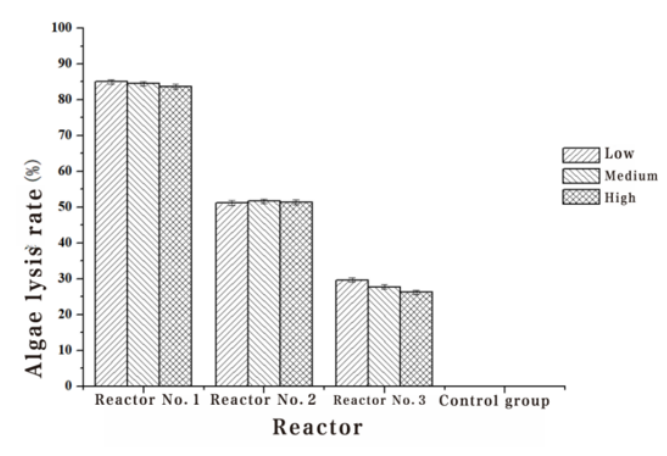
Figure 2. Effect of three addition methods with Phanerochaete chrysosporium on Chl-a. Table 3. The DHA variation in three addition methods with Phanerochaete chrysosporium . Inlet Wate r (ug TPF/mL.h)